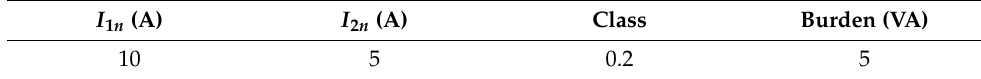
Table 4. Current transformer CT2: rated specifications.